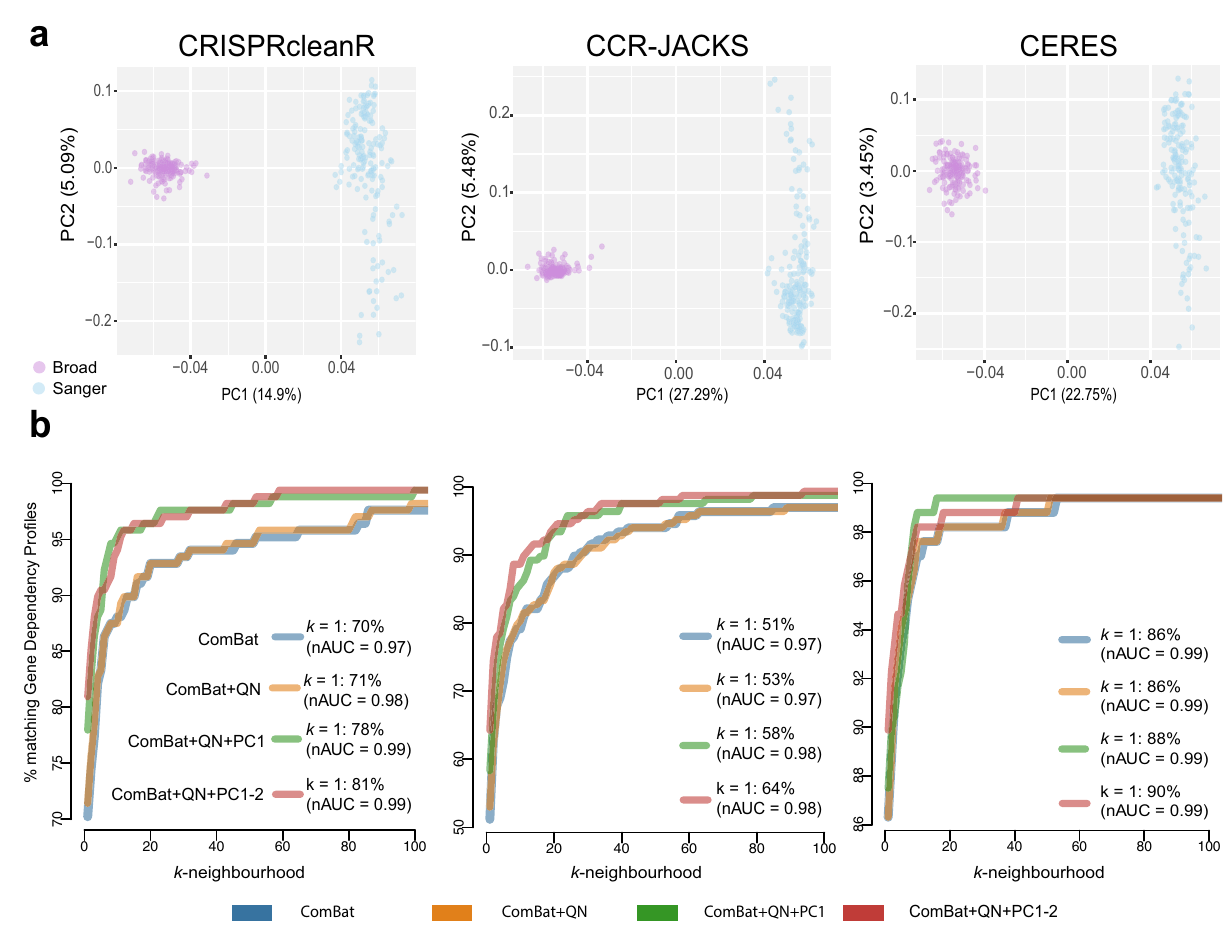
Fig. 3 Batch effect assessment and correction. a Principal component plots of the dependency pro fi le across genes (DPGs) for cell lines screened in both Broad and Sanger studies and pre-processing methods. Screens are colored by the institute of origin with purple indicating a screen performed at the Broad and blue a screen from the Sanger. b Percentages of cell line DPGs that have the corresponding (same cell line) DPG screened at the other institute among their k most correlated DPGs (the k- neighborhood). Results are shown across different pre-processing methods, CRISPRcleanR, CRISPRcleanR with JACKS (CCR-JACKS) and CERES (in different plots) and different batch correction pipelines (as indicated by the different colors). The different batch correction pipelines are ComBat only (ComBat, blue), ComBat followed by quantile normalization (ComBat + QN, orange), and ComBat + QN with either the fi rst PC removed (ComBat + QN + PC1, green) or fi rst two PCs removed (ComBat + QN + PC1-2, red). Correlations between DPGs are computed using a weighted Pearson correlation metric. Genes with higher selectivity have a larger weight in the correlation calculation. As a measure of selectivity, we used the average (across the two individual datasets) skewness of a gene ’ s dependency pro fi le across cell lines. The proportion of cell lines closest to their counterpart from the other study ( k = 1) is shown and the normalized areas under the curves (nAUC) are shown in brackets. The x -axis values are restricted to between 1 and 100 to highlight the range over which performance differences are visible between Identi fi cation of lineage subtypes . Many dependencies are Fig. 4d). Under each pre-processing method the removal of one or two principal components resulted in an increased AMI between cell line DPGs clusters and tissue lineages. We next measured the ability of each of the integrated datasets to separate cell lines according to lineage subtypes. The integrated datasets contain over 100 lung cell lines. These cell lines can further be strati fi ed into subtypes such as small cell lung carcinoma and mesothelioma, while clinical subtypes such as PAM50 classi fi cations are available for the breast cancer cell lines (Fig. 2c). To quantify the clustering of cell lines by subtype we calculated the correlation between all cell lines DPGs, and for a given query cell line the rank of the cell line with most correlated DPG to the query from the same subtype ( k -rank). For the lung cancer cell lines, the percentage of cell lines whose closest neighbor was from the same subtype ( k = 1) was greatest for CERES (64 – 65% across batch correction methods) followed by CRISPRcleanR (61 – 64%) and CCR-JACKS (50 – 57%), with slight